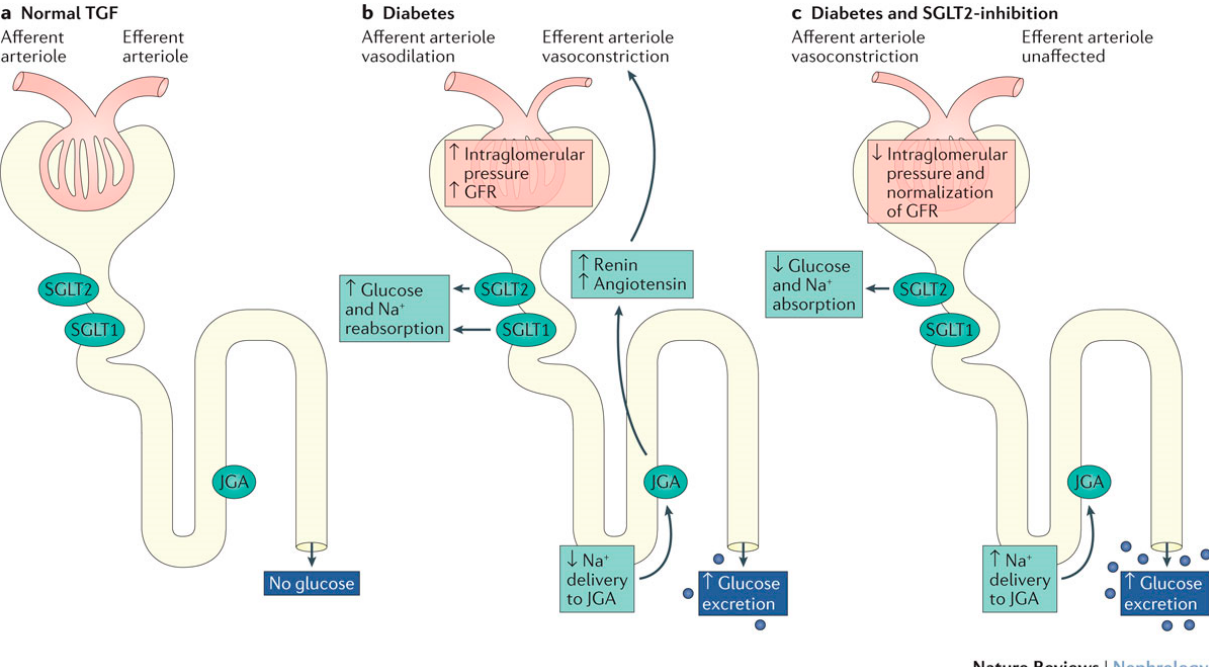
Figure 2. Glomerular effects of SGLT2is. In states of normal TGF, no glucose is delivered to the JGA. However, with glucosuria, TGF is abnormal, resulting in increased efferent arteriolar constriction and hyperfiltration. With SGLT2 inhibition, restoration of TGF occurs, lowering intraglomerular pressure and normalization of GFR. Reprintede with permission from DeFronzo RA, et al. Nat Rev Nephrol. 2017 [58]. Copyright © 2016, Nature Publishing Group, a division of Macmillan Publishers Ltd. All rights reserved. GFR, glomerular fi ltration rate; JGA, juxtaglomerular apparatus; Na + , so- dium; SGLT1, sodium-glucose cotransporter 1; SGLT2, sodium-glucose cotransporter 2; SGLT2i, so- dium-glucose cotransporter 2 inhibitor; TGF, tubular glomerular feedback.